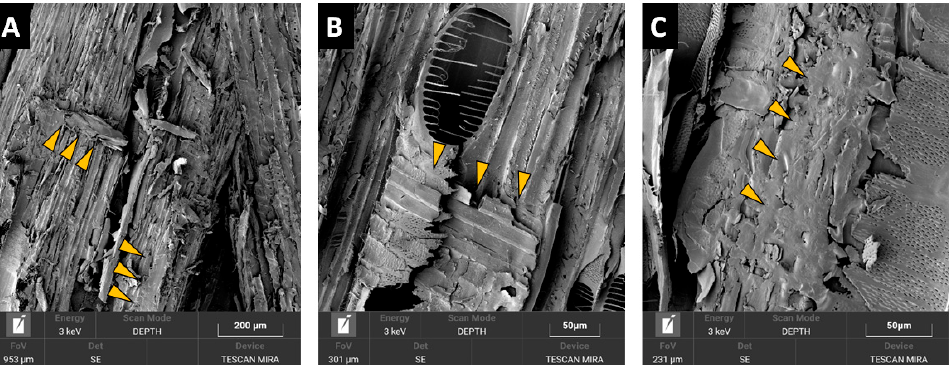
Figure 10. SEM images of the sample from PB board made from wood particles bonded with 4% pMDI (arrows indicating different failures).